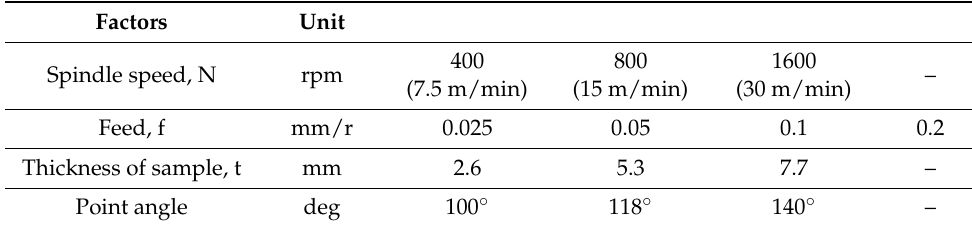
Figure 1. Experimental setup for measuring thrust forces and torque in drilling GFRP composites using CNC milling machine and Kistler dynamometer. The temperature was measured by: ( a ) instrumented drill with two thermocouples and ( b ) IR camera. Table 4. Levels of the variables used in the